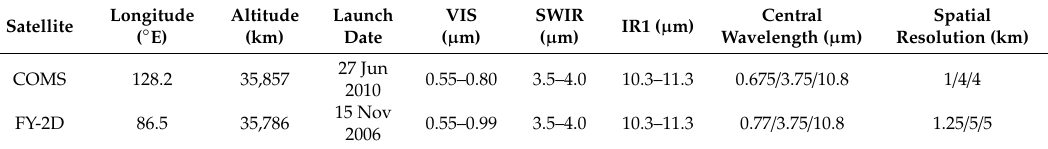
Information about the COMS and FY-2D dual geostationary satellites used in the nearly-simultaneous observations of low stratus and fog near the Korean Peninsula [29,30]. Please see Table A1 for the